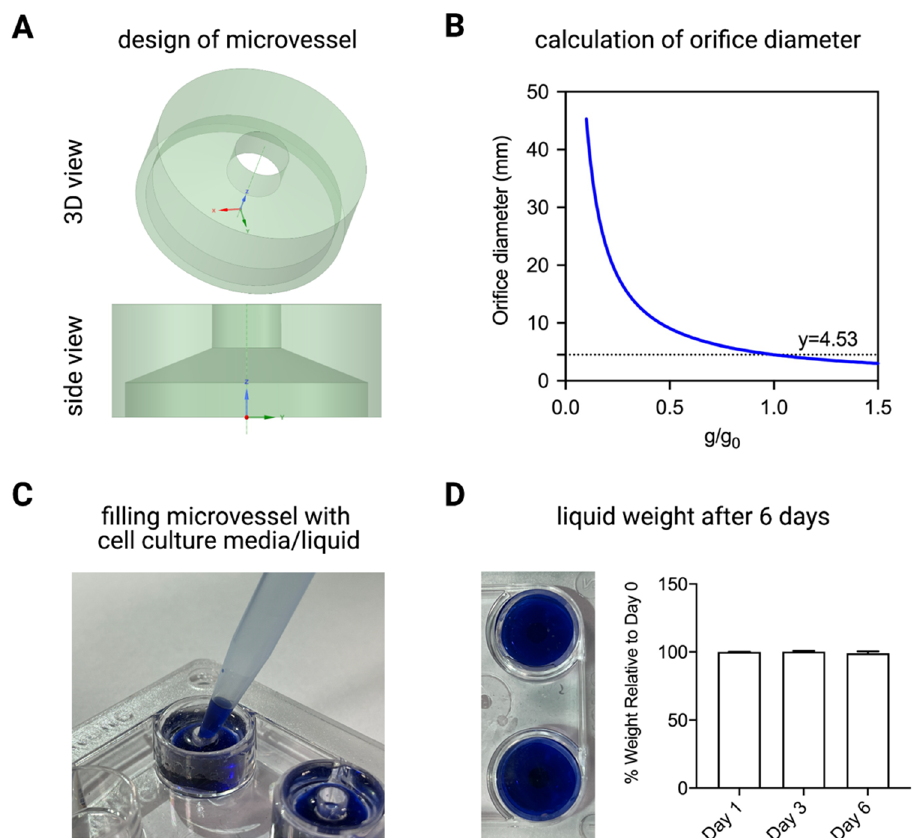
Figure 4. Microvessel design. ( A ) Design of microvessel seen from the top and side view. ( B ) Calcu- lation of the orifice diameter to ensure surface tension force prevents loss of liquid or culture media from 4-well plate at different gravity levels, since the microvessels can be used on reduced gravity platforms that may also momentarily experience hypergravity. ( C ) Visual representation of the ease of filling the microvessel with culture media or liquid. ( D ) Visual representation of full microvessels with no air bubbles and graph depicting the percent of weight in the vessel after 6 days relative to day 0. Data are presented as mean ± SD. Experiments were performed in at least 3 replicates.